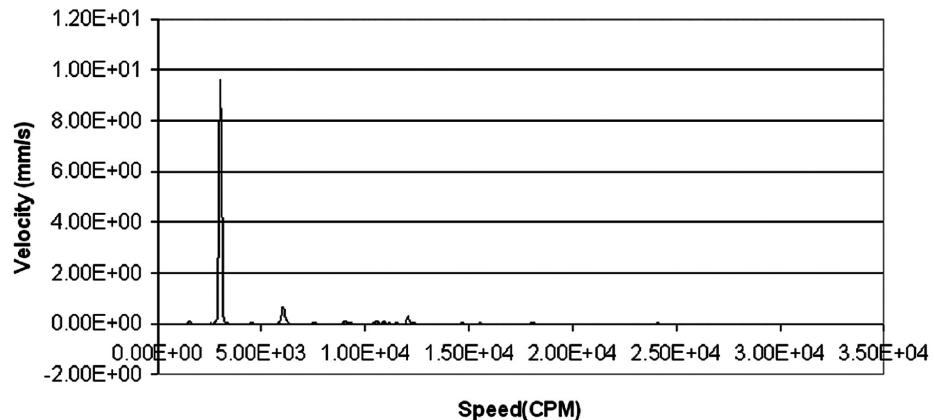
Fig. 7. Horizontal vibration spectrum of overall amplitude 28.6 mm/s.